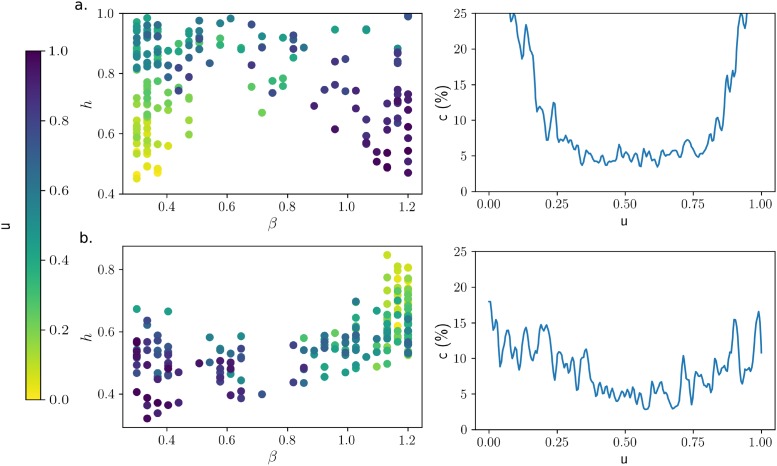
Best decompositions of artifical signals.Scatter plot, left: distribution of generated signals in the (β, h) plane. Right: contrast against the control parameter u. a. Simulation 1: Modulated noises from time windowing (u = 0) to frequency windowing (u = 1). Samples at u = 0.5 are neither modulated in time nor in frequency (white noise). This simulation shows that β is related to localization for noise sounds: time localization corresponds to a minimal β value (as for stop onsets), frequency localization corresponds to a maximal β value (as for sibiliant fricatives). b. Simulation 2: Radiated sounds at the output of a uniform cylindrical waveguide with different radii, from r = 0.2 cm (u = 0) to r = 1.3 cm (u = 1). Greater apertures means greater losses, wider bandwidths, hence lower values of β.